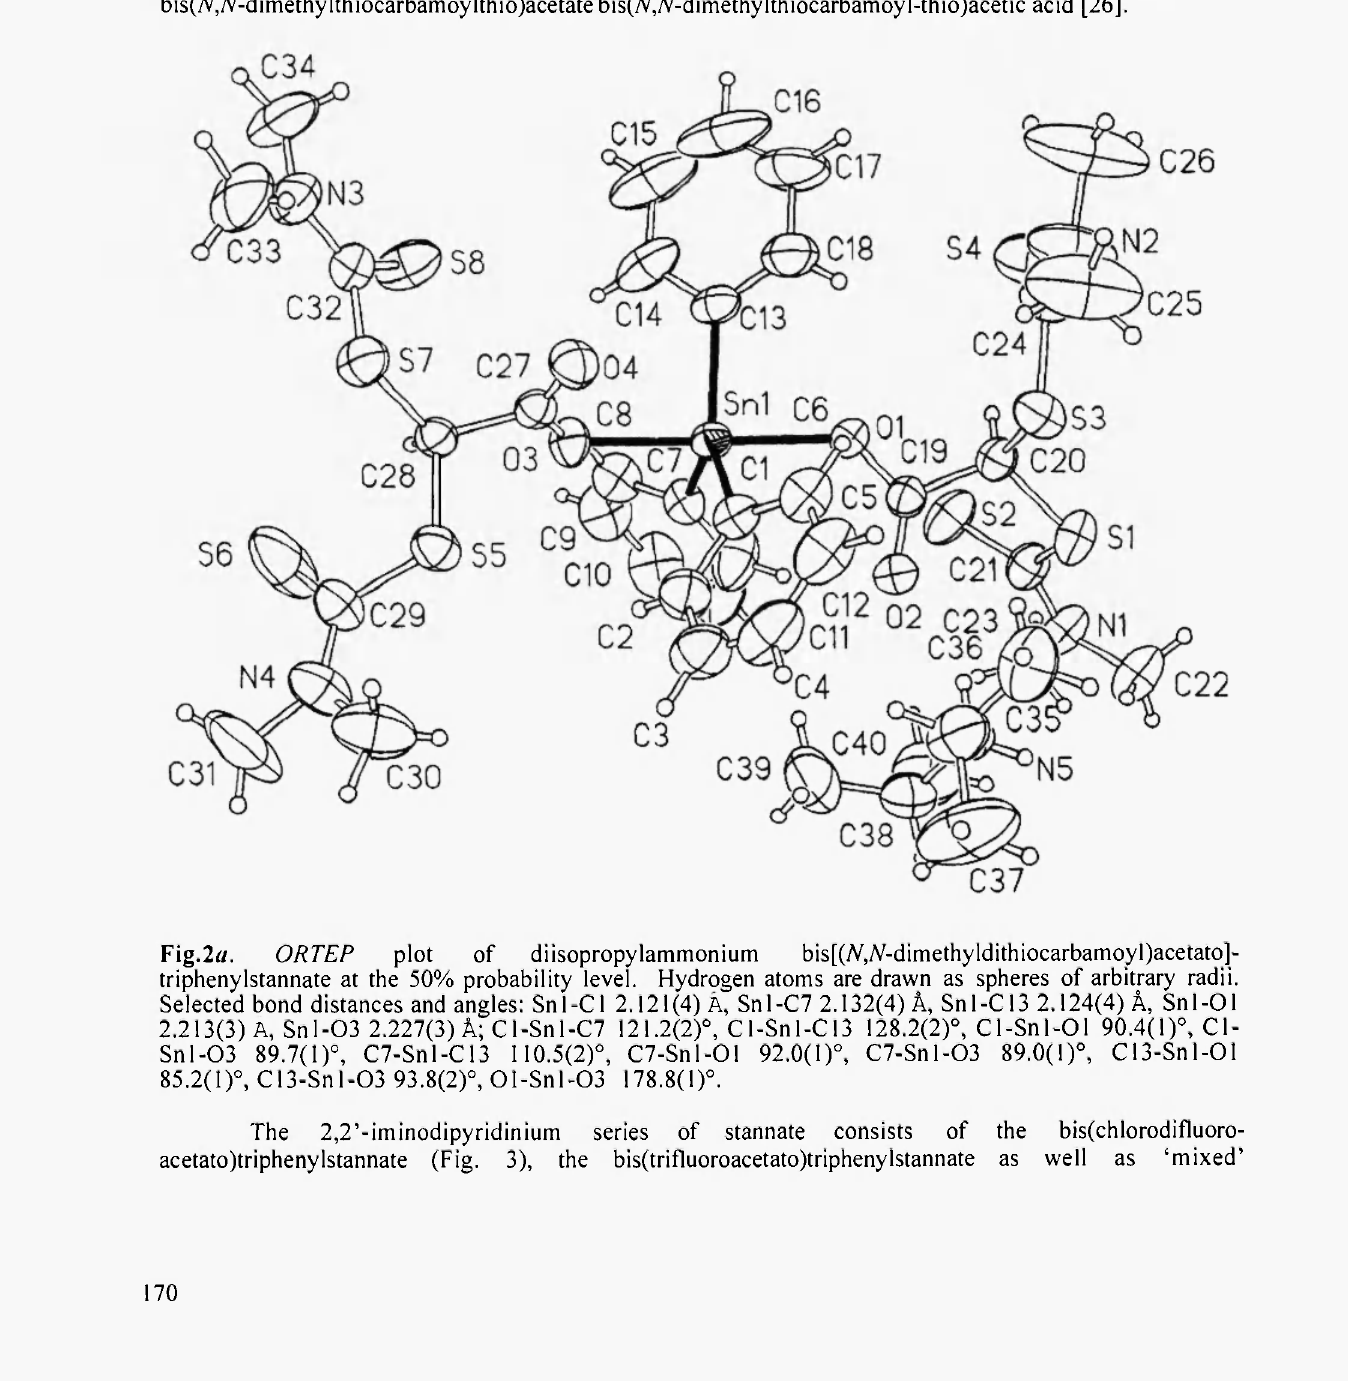
Fig.2«. ORTEP plot of diisopropylammonium bis[(N,A'-dimethyldithiocarbamoyl)acetato]- triphenylstannate at the 50% probability level. Hydrogen atoms are drawn as spheres of arbitrary radii. Selected bond distances and angles: Snl-Cl 2.121(4) A, Snl-C7 2.132(4) A, Snl-C13 2.124(4) A,